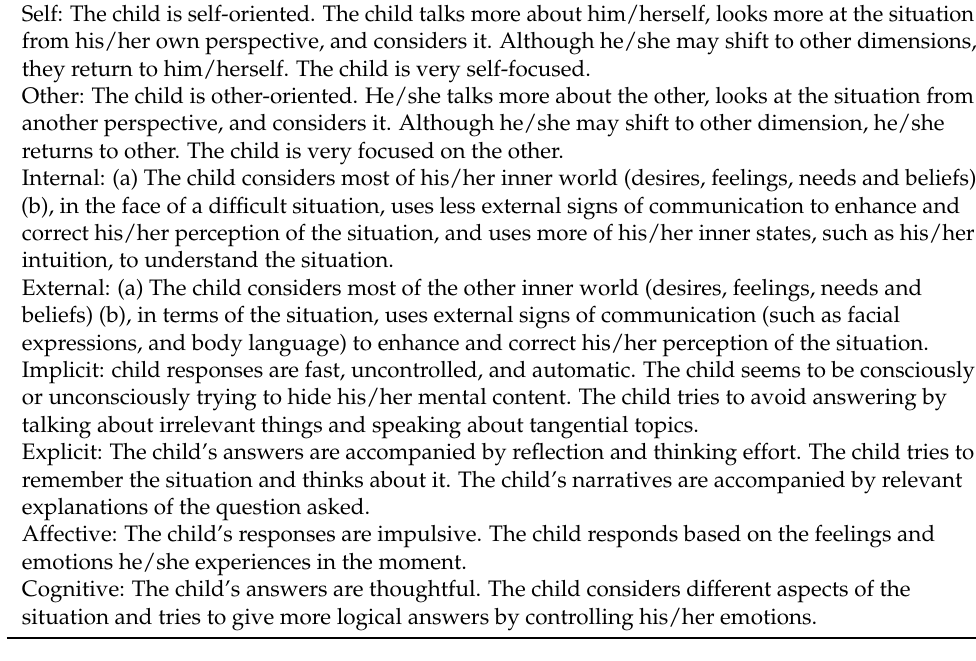
Table 2. Codebook used to extract the dimensions of mentalization from children’s